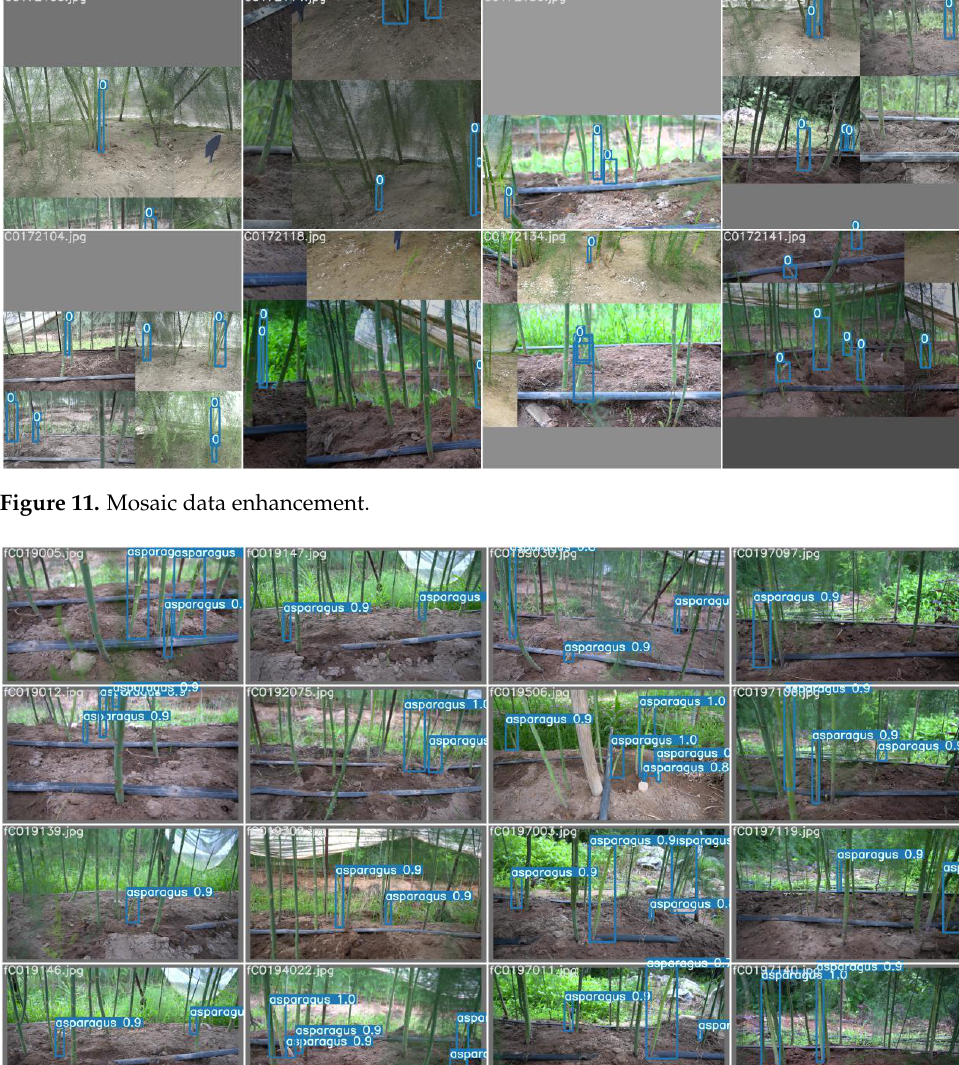
Figure 13. Detection effect. 4. Discussion This study proposed the YOLOv5-CB algorithm to detect asparagus in summer and autumn, whose environments are more complex. D ue to the evolution of YOLO, the recognition precision of this algorithm increased by 11.88% to 97.88%, and the F1 value increased by 0.24 to 0.97 compared with Peebles’s study of spring asparagus recognition by Faster-RCNN. The recognition success rate increased by 22.88%, and the radar camera was replaced by the depth camera, c ompared with Sakai’s research. The recognition ac- curacy has been significantly improved. The cost of the machine can be reduced without requiring expensive equipment, such as laser sensors. Similarly, Zhang replaced the PANet with ASFF in the neck and added a CBAM attention mechanism to the backbone to realize the identification of key growth stages of lettuce. However, we still observed 24 cases of false or missed detection when testing on the test dataset. The analysis of these